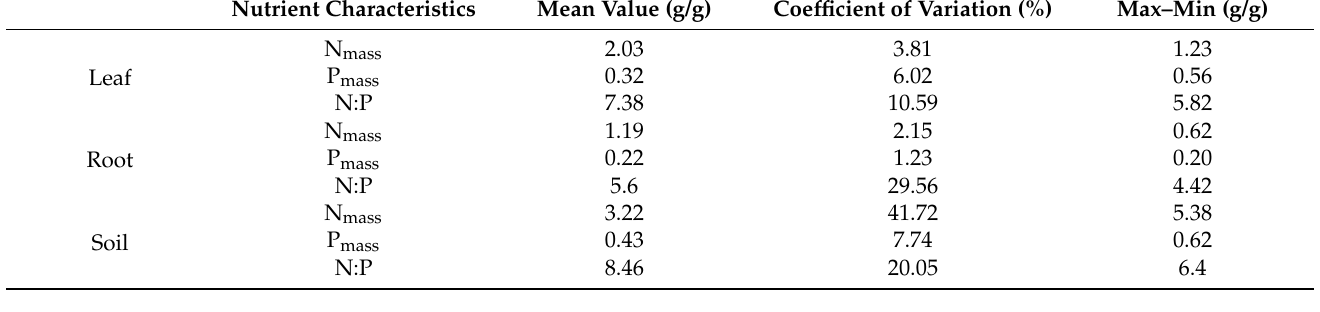
Figure 1. A comparison of the differences in the N mass ( A ), P mass ( B ), and N/P ( C ) of different organs (leaf and root). * represents p < 0.05, ** represents p < 0.01, **** represents p < 0.0001. Table 1. Variations in the N mass , P mass and N/P ratio of leaves, roots and soil. Nutrient Characteristics